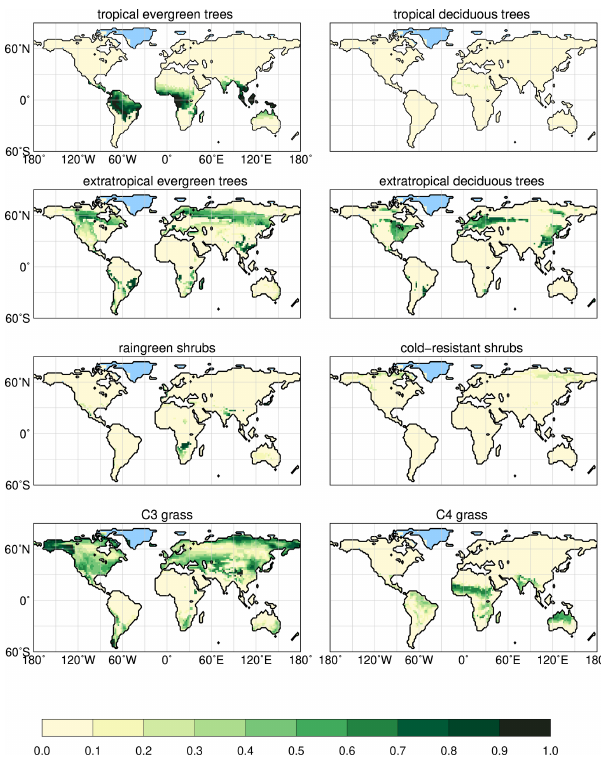
Figure A1. Simulated plant functional type distributions at 2.15ka.